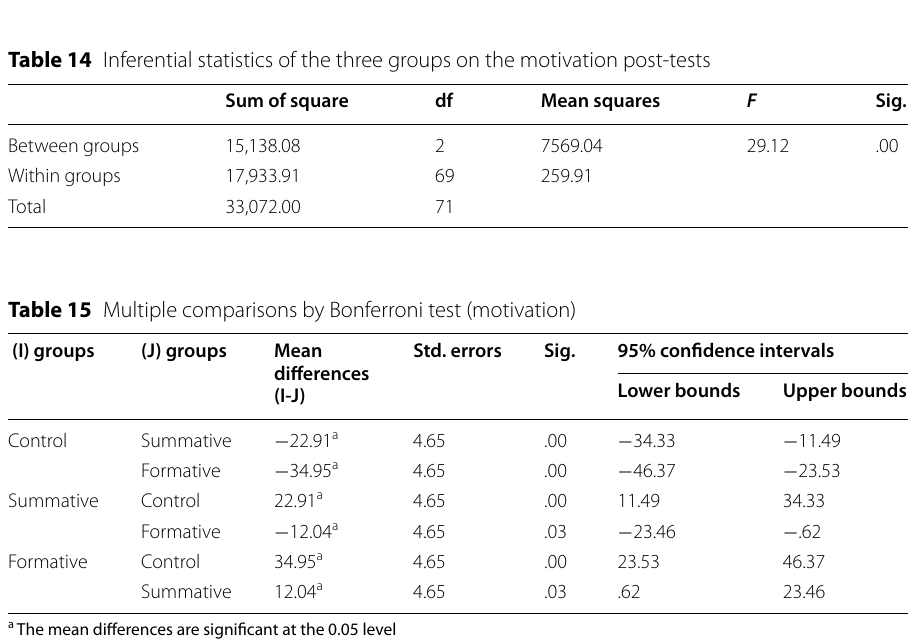
a The mean differences are significant at the 0.05